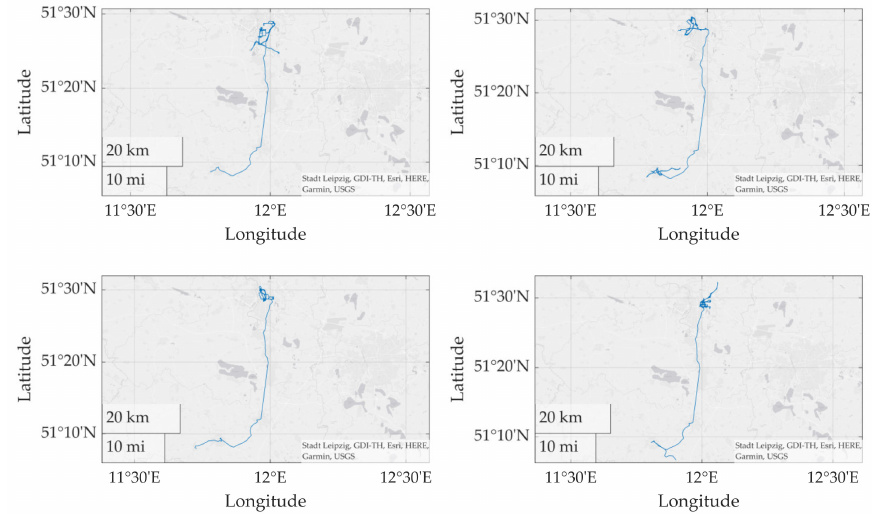
Figure 5. Selected routes for 4 of the 60 vehicles in the fleet used in analyses.